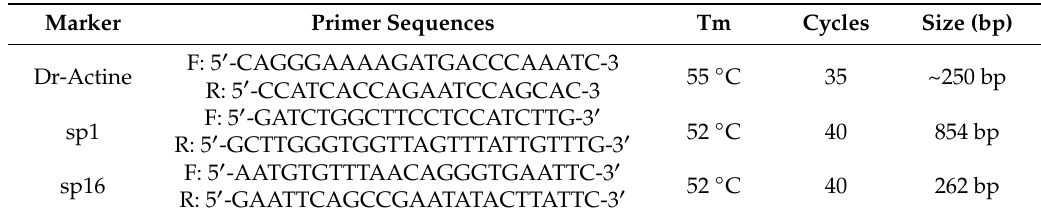
Table 1. List of primers used in this